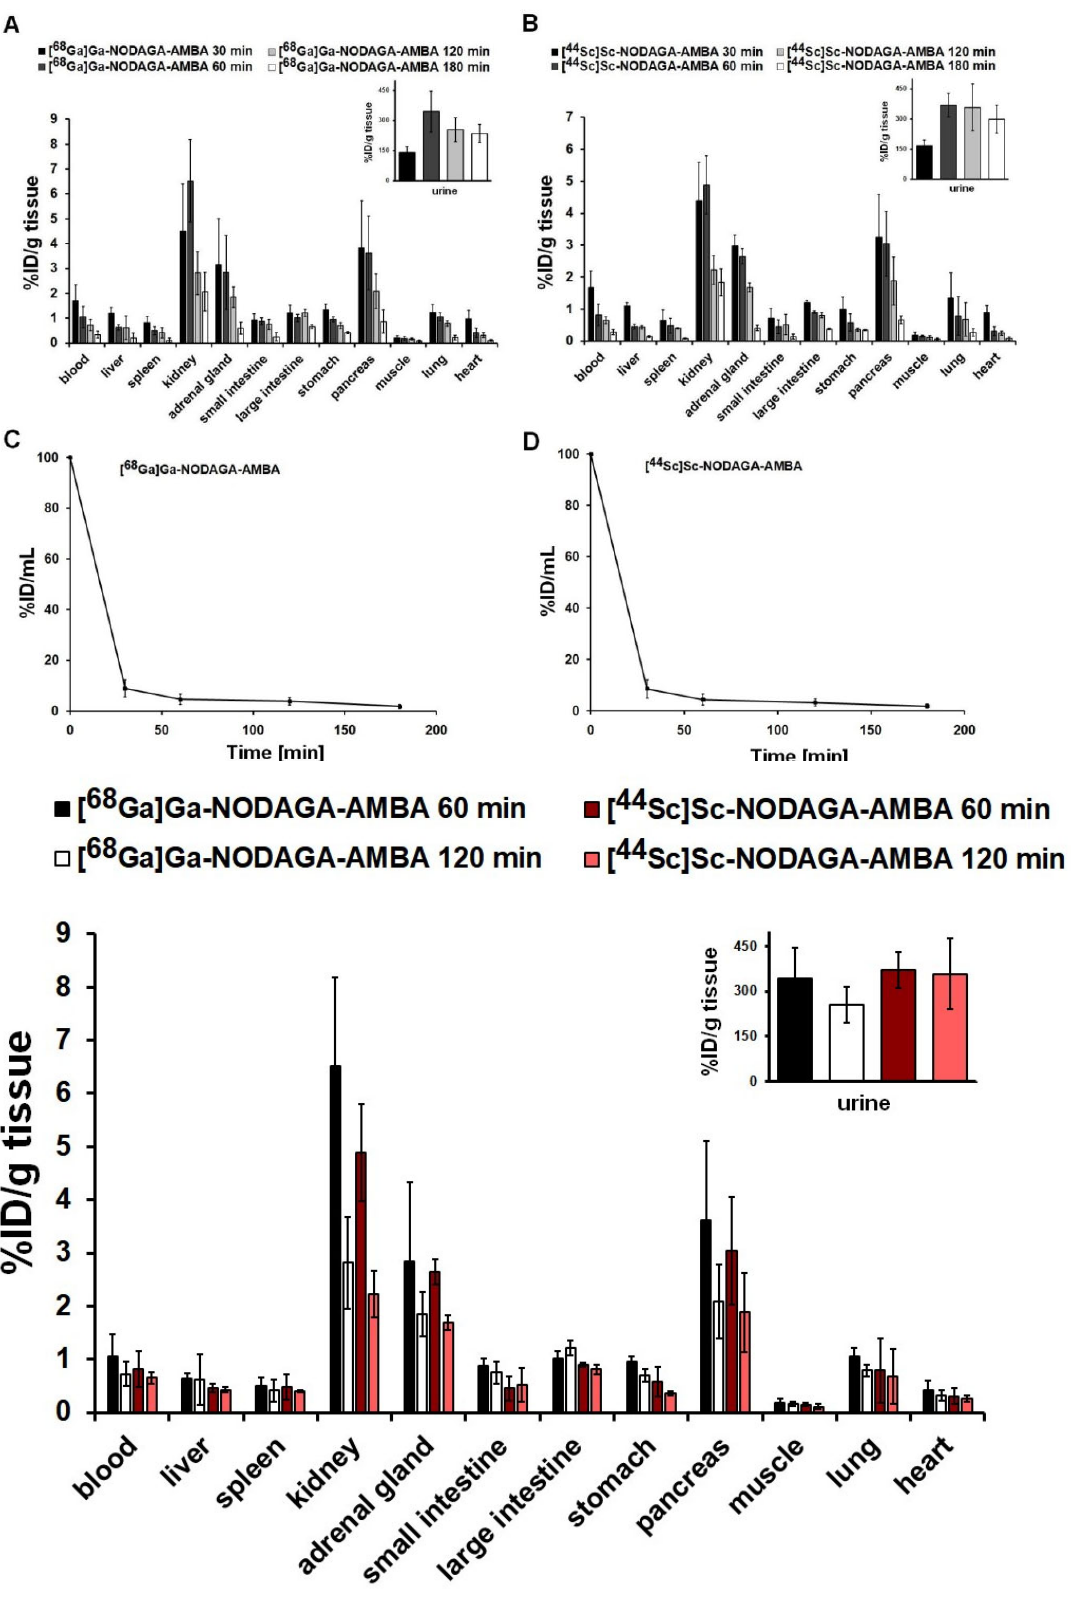
Figure 3. Ex-vivo biodistribution data for [ 68 Ga]Ga-NODAGA-AMBA ( A ) and [ 44 Sc]Sc-NODAGA- Figure 3. Ex ‐ vivo biodistribution data for [ 68 Ga]Ga ‐ NODAGA ‐ AMBA ( A ) and [ 44 Sc]Sc ‐ NODAGA ‐ AMBA ( B ). Quantitative %ID/g tissue analysis of ex ‐ vivo biodistribution data (n = 5 control AMBA ( B ). Quantitative %ID/g tissue analysis of ex-vivo biodistribution data (n = 5 control